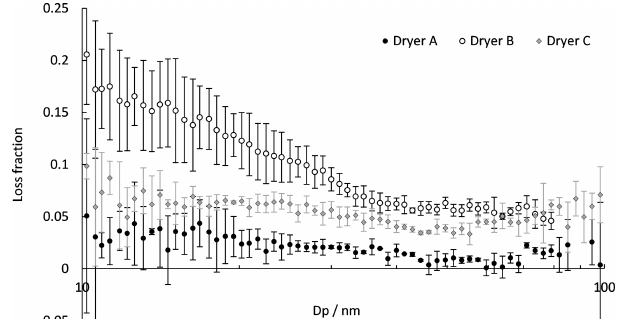
Figure 3. Fraction of total particle concentration lost due to diffu- sion in three dryers, as a function of particle diameter, D p . Error bars indicate 1 standard deviation from two to three